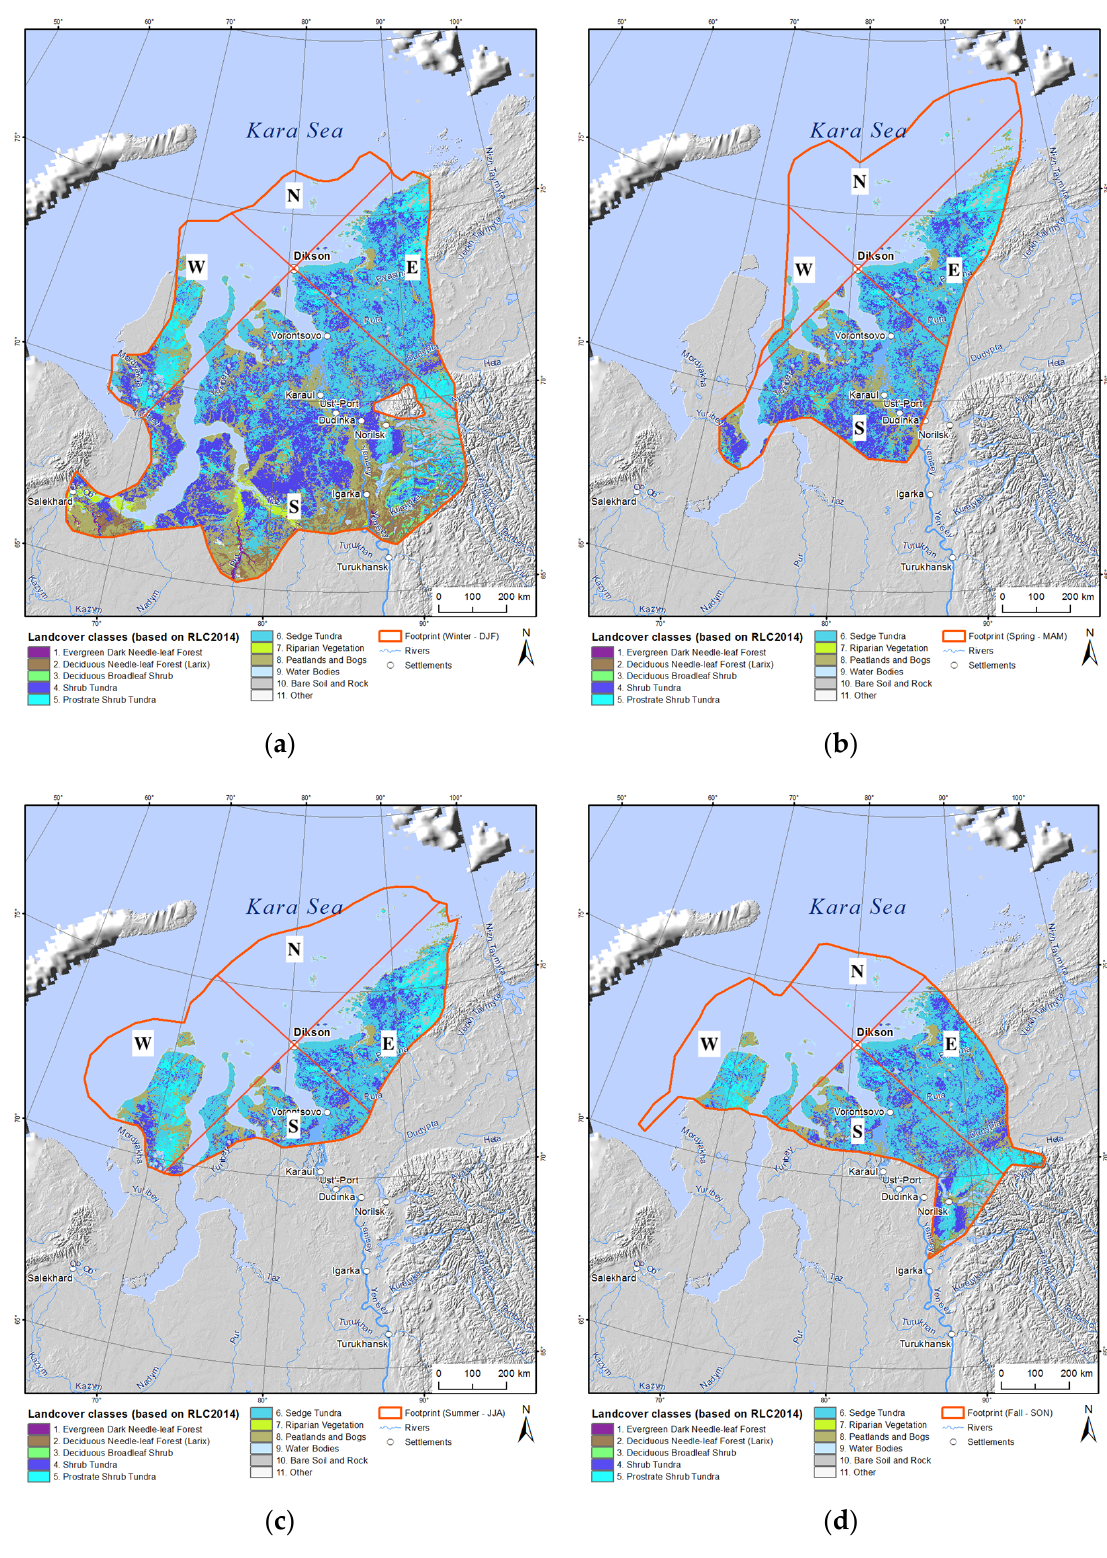
Figure 4. Footprint for the measurement station “DIAMIS” with land cover classes (RLC 2014) throughout the seasons where ( a ) Winter (DJF), ( b ) Spring (MAM), ( c ) Summer (JJA), and ( d ) Fall (SON). Four geographical domains (N—Northern; S—Southern; W—Western; E—Eastern) are defined based on the merging corresponding ranges of the angular distributions.